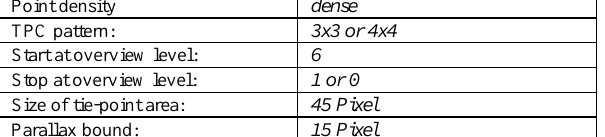
Table 3: MATCH-AT – Strategy and matching parameters